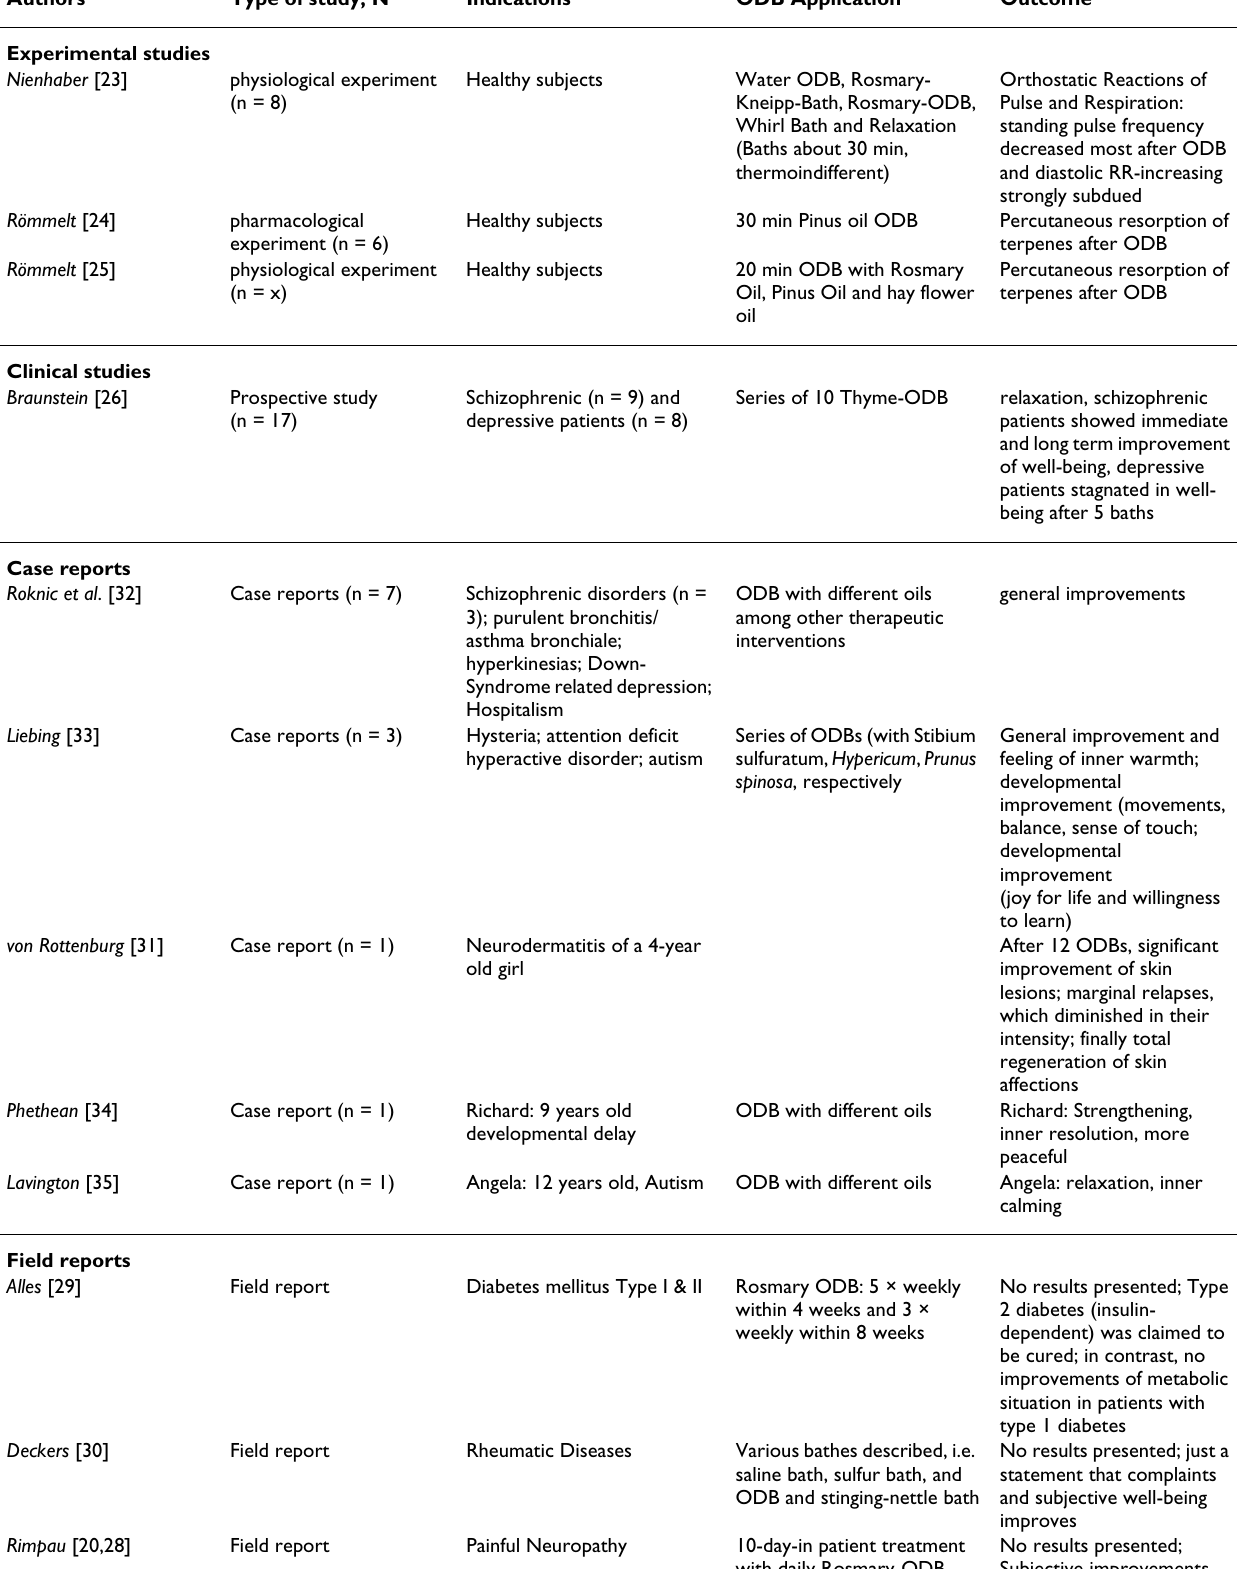
Table 1: Design of clinical studies on the effects of ODB and outcome parameter